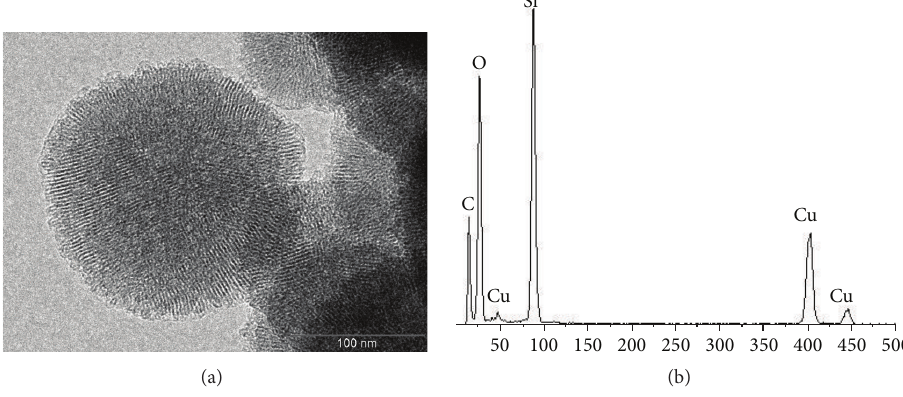
Figure 2: TEM image (a) and EDX analysis (b) of the synthetized SiO 2 mesoporous